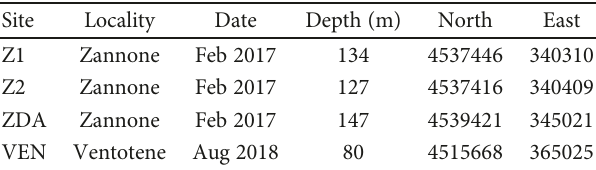
Figure 2: Bubbling gases and white patches associated with warm waters vented o ff Ventotene Island. The hydrothermal fl uids occur on a fl at area, in water depth varying from 80 to 85m. Table 1: Location and information of the collected samples. The coordinate reference system is UTM WGS84 zone 33